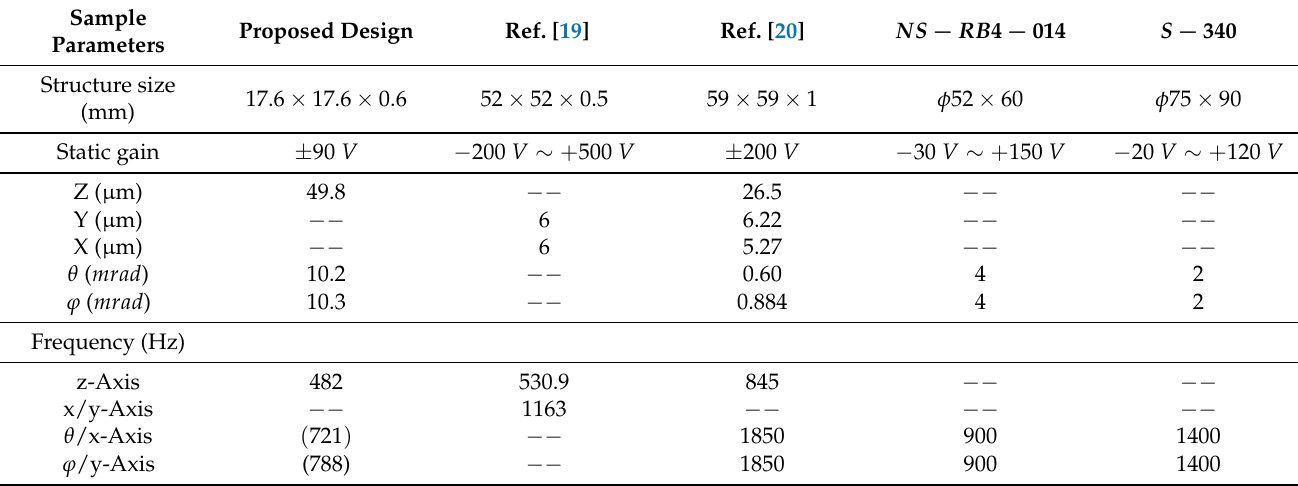
Table 4. Comparison of the proposed design and some existing